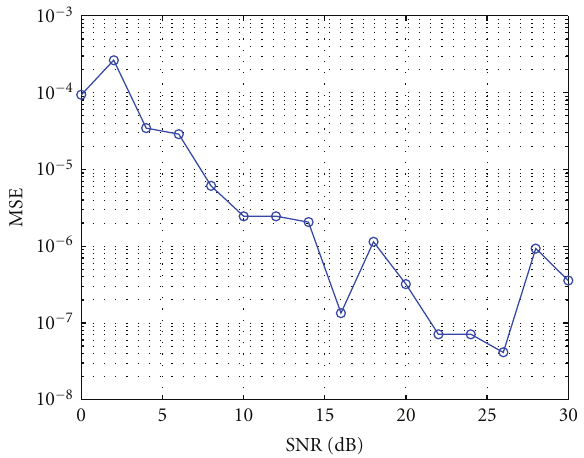
Figure 14: Preamble pilot-based measured MSE of CFO versus SNR performance curve. CFO = 10KHz.